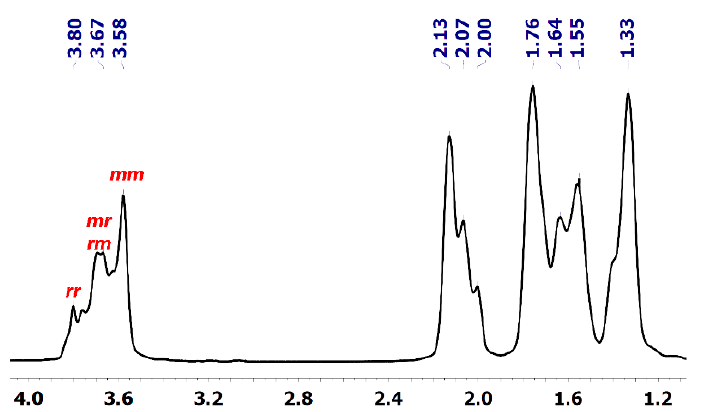
Figure 1. 1 H NMR spectrum of PCHO (600 MHz, C 6 D 6 , 25 °C) (entry 5 of Table 1) with the signals for the isotactic ( mm ), heterotactic ( mr and rm ) and syndiotactic ( rr ) triads labelled.